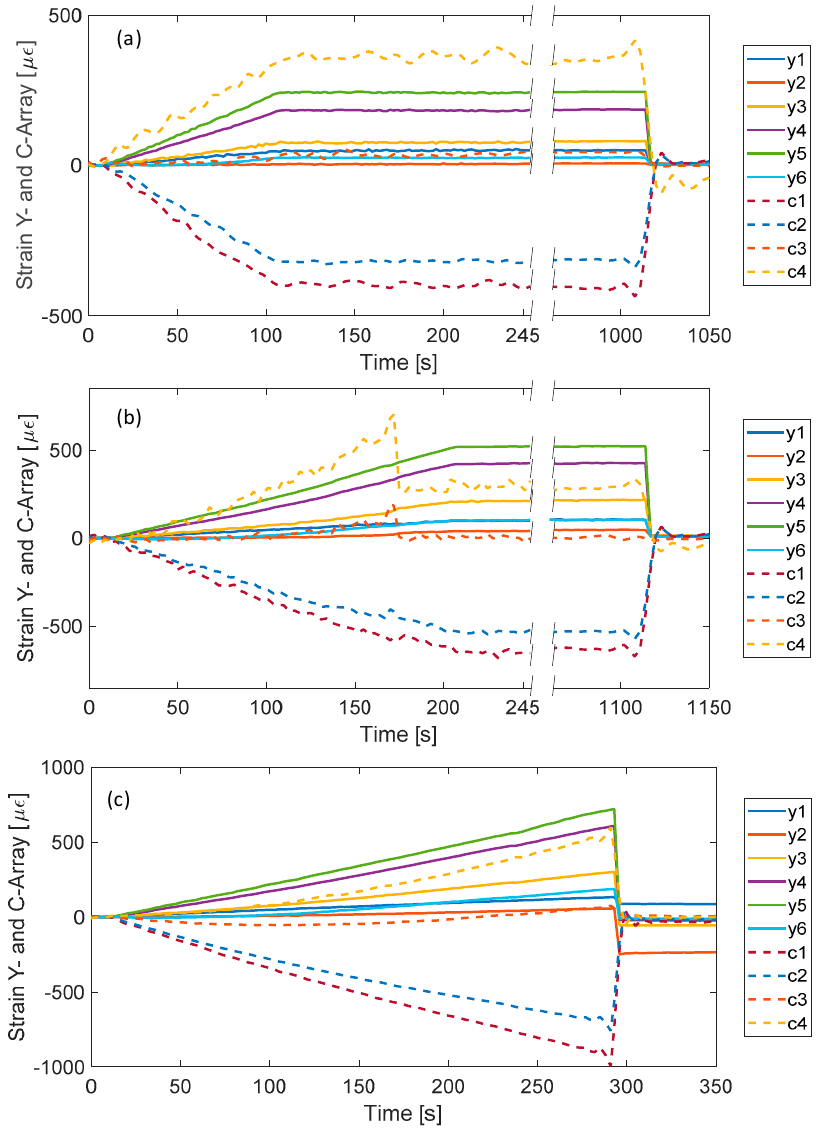
Figure 8. Time response of all FBG sensors in different test sections: ( a ) test A, ( b ) test B, and ( c ) test C.